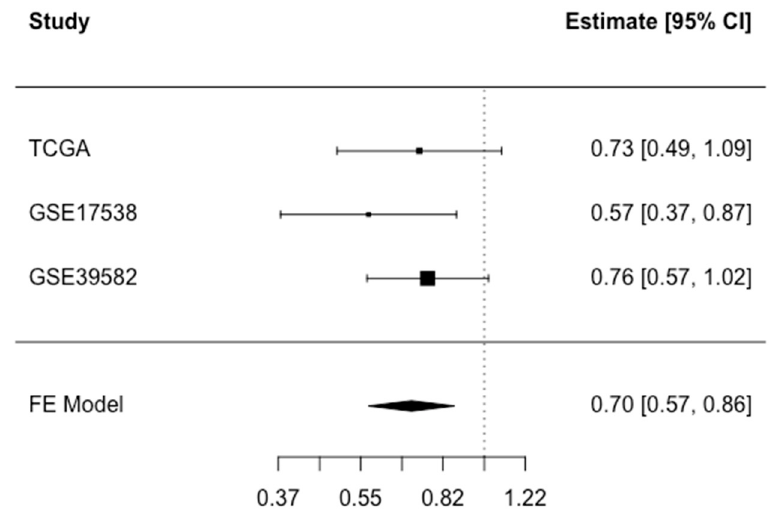
Figure 2. Meta-analysis of overall death associated with CFTR expression dichotomized at median in the TCGA COADREAD, GSE17538, and GSE39582 studies. Fixed Effect (FE) meta-analysis HR (CI 95%): 0.70 (0.57–0.86) for high versus low CFTR expression. Test for heterogeneity p = 0.54.